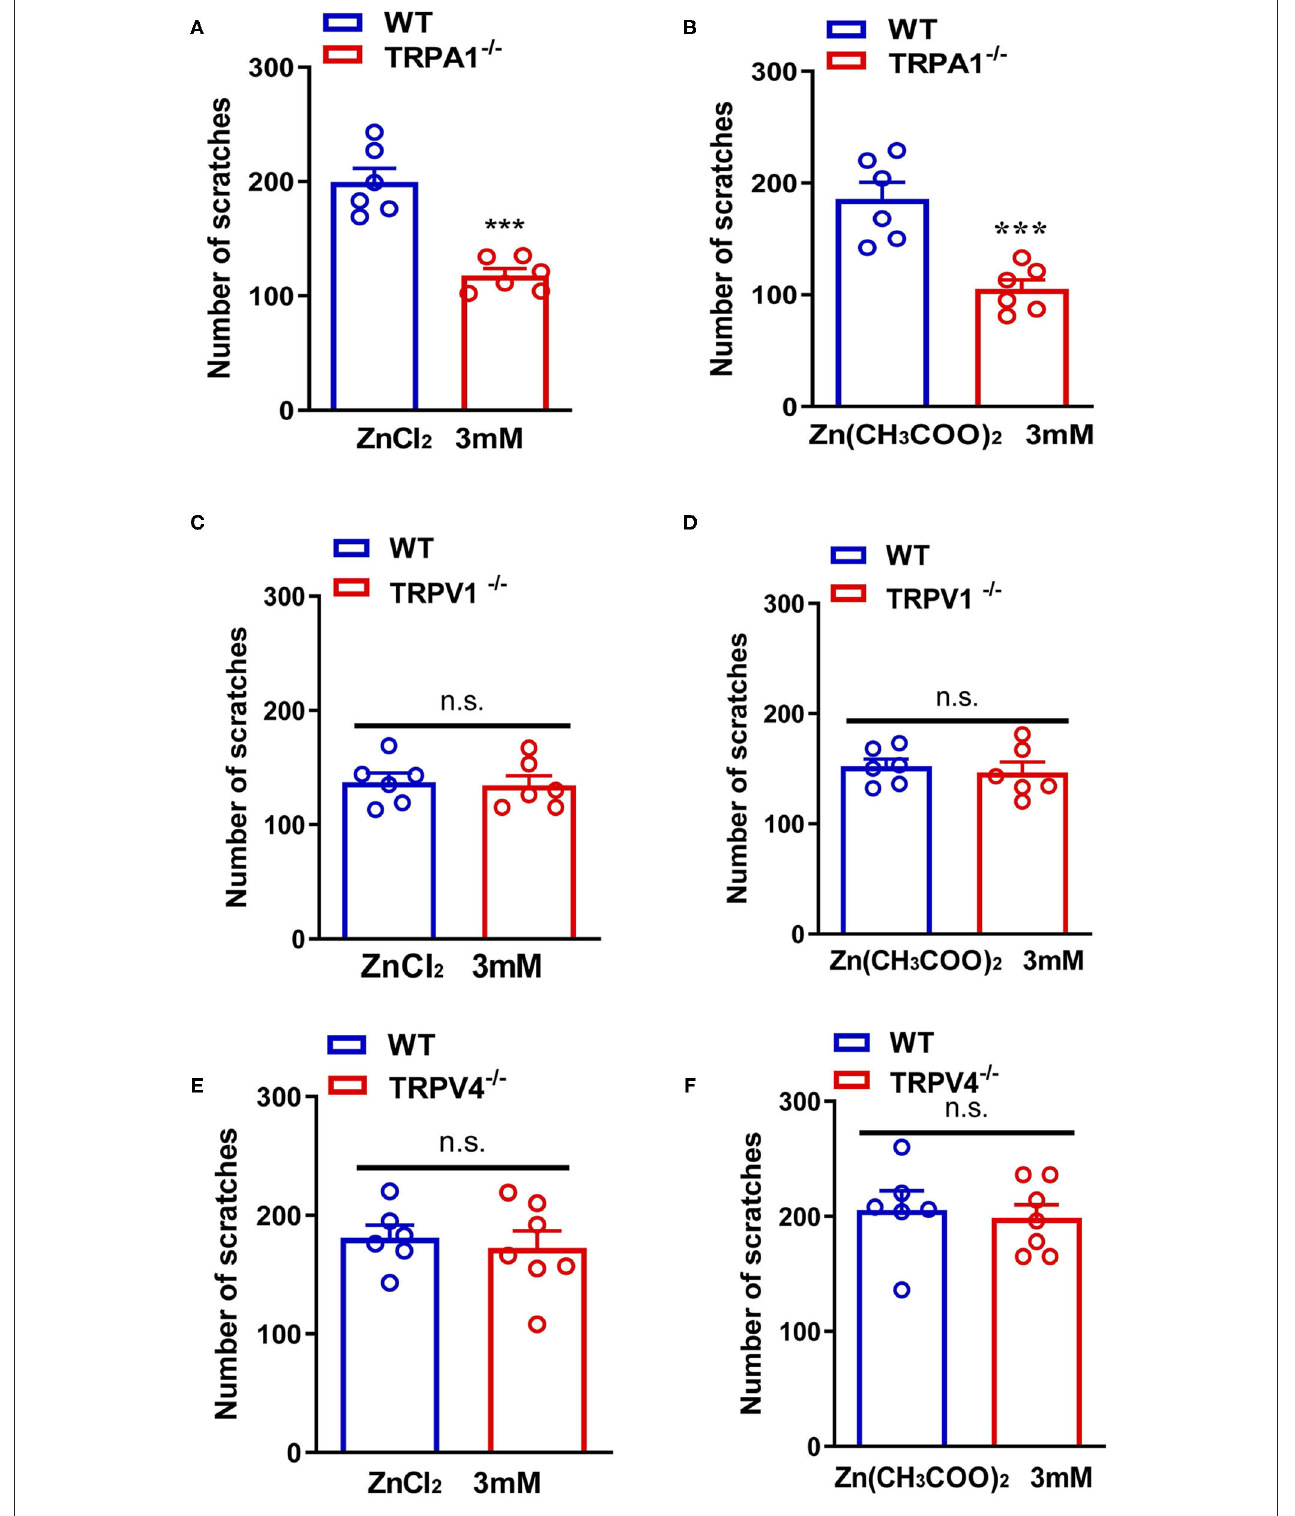
FIGURE 4 | Transient receptor potential A1 (TRPA1) was involved in Zn 2 + induced itch in mice, but TRPV1 and TRPV4 were not involved. (A,B) ZnCl 2 [ (A) ; 3mM]-evoked and Zn(CH 3 COO) 2 [ (B) ; 3mM]-evoked acute itch were reduced in Trpa1 − / − mice. (C,D) ZnCl 2 [ (C) ; 3mM]-evoked and Zn(CH 3 COO) 2 [ (D) ; 3mM]-evoked acute itching were not expressed in Trpv1 − / − mice. (E,F) ZnCl 2 [ (E) ; 3mM]-evoked and Zn(CH 3 COO) 2 [ (F) ; 3mM]-evoked acute itch were also not expressed in Trpv4 − / − mice (*** P < 0.001 vs. WT mice, unpaired Student’s t -test; n = 6–8 per group). All data are expressed by means ± SEM. n.s., not significant.